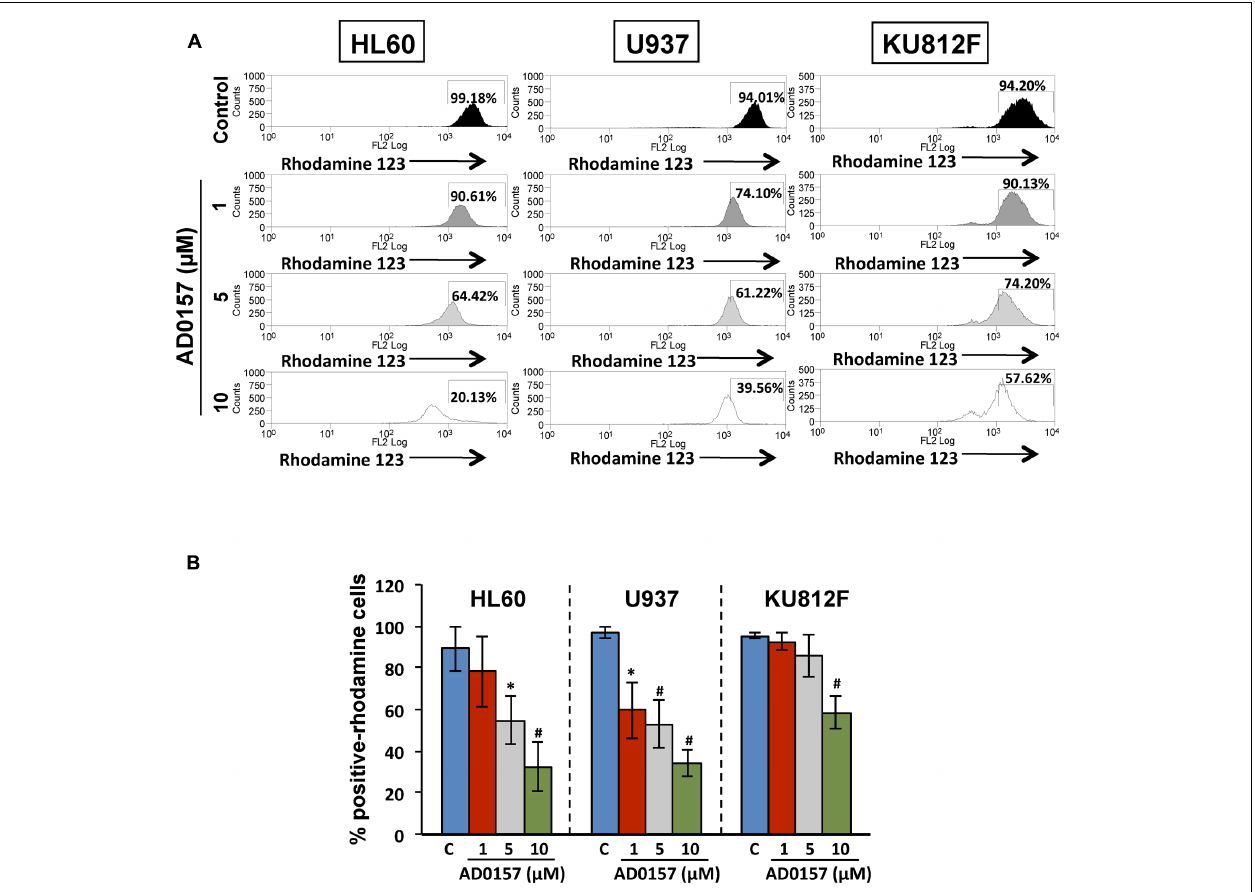
FIGURE 6 | Mitochondrial membrane potential is involved in the apoptogenic activity of AD0157. (A) Flow cytometry histograms with the relative fluorescence intensity of human leukemia cells treated or not with AD0157 followed by Rhodamine 123 incubation. AD0157 decreases the Rhodamine 123 uptake in HL60, U937 and KU812 cells due to the mitochondrial membrane potential loss. Percentage of Rhodamine 123-positive cells is indicated in the histograms. (B) Quantification of Rhodamine 123-positive cell percentages, expressed as means ± SD from three independent experiments. ∗ p < 0.05 and # p < 0.005 versus